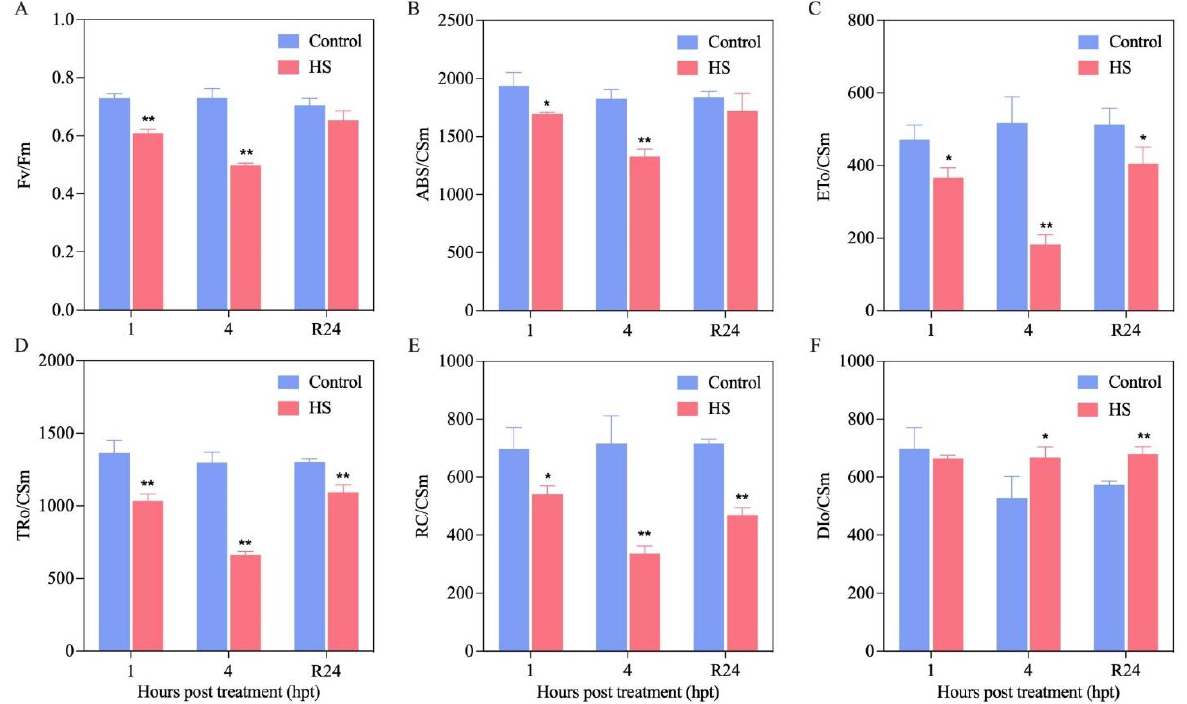
Figure 4. Effect of HS treatment on chlorophyll fluorescence. ( A ) Fv/Fm (the maximum quantum efficiency of PS Ⅱ photochemistry), ( B ) ABS/CSm (absorption flux per CSm approximated), ( C ) ETo/CSm (electron transport flux per CSm), ( D ) TRo/CSm (trapped energy flux per CSm), ( E ) RC/CSm (percentage of active/inactive reaction centers per CSm), ( F ) DIo/CSm (dissipated energy flux per CSm). Asterisks indicate statistical significance (* 0.01 < p < 0.05, ** p < 0.01, Student’s t -test) of differences between the HS treatment and control at three sampling time-points. Data represent mean values ± SD from three independent experiments.